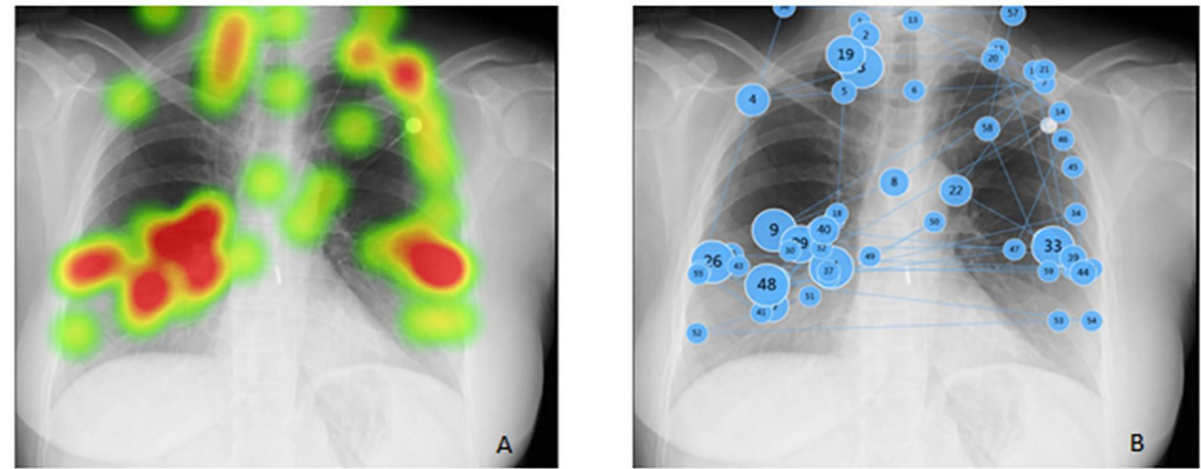
Figure 3. The time spent and location of the gaze by the medical student looking at chest